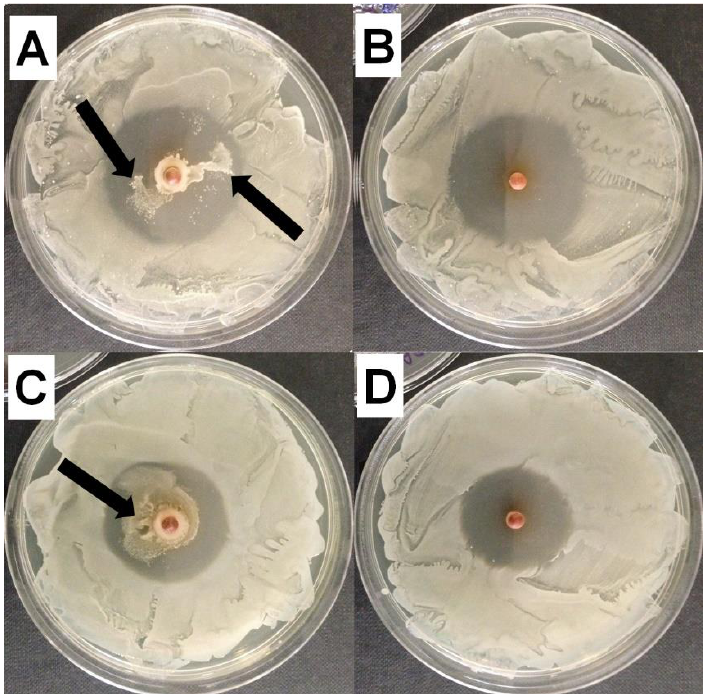
Figure 2. Representative image of the Zones of Inhibition (ZOI) observed with ( A , B ) S. epidermidis ATCC 35984 and( C , D ) S. aureus NCTC 13143 EMRSA-16 at day 20 of rifampicin and vancomycin in combination, showing no evidence of resistant colonies ( B , D ) and rifampicin alone ( A , C ) showing potential resistant mutant colonies growing within the ZOI (black arrows).